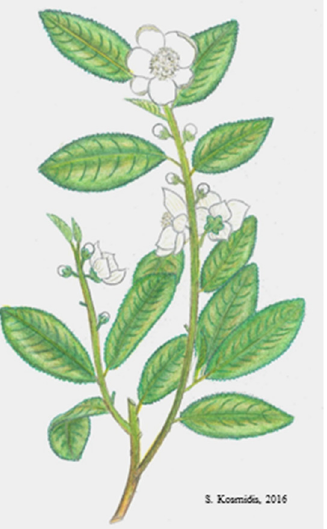
Figure 1. Drawing of the Camellia sinensis plant.